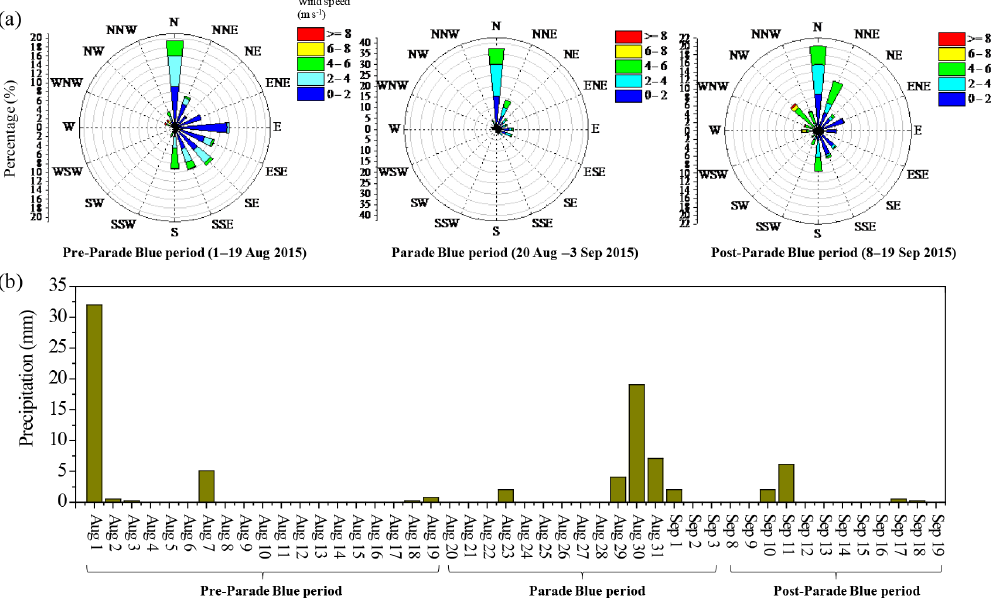
Figure 8. The frequency distributions of wind directions and speeds (colour demarcation) (a) and daily precipitation amount (b) in Beijing during the pre-Parade Blue, Parade Blue and post-Parade Blue